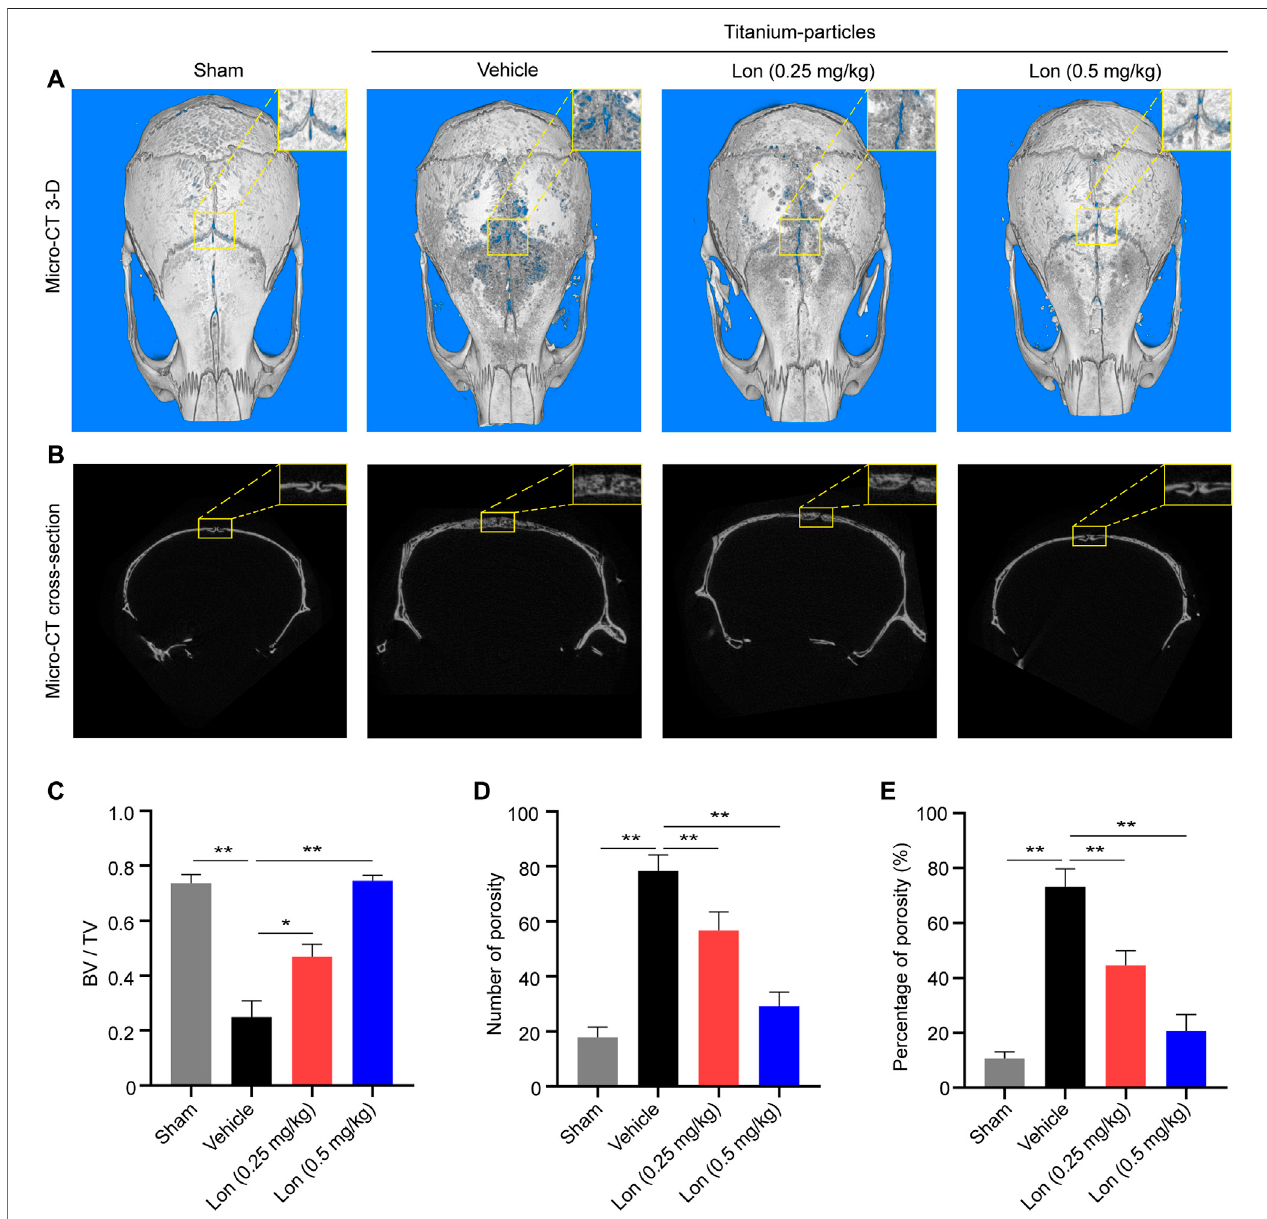
FIGURE3 | Lonprevents titanium particle-induced osteolysis and bone loss in vivo . (A) RepresentativeMicro-CT3-D constructional images showing thattitanium particle-induced osteolysis was prevented by Lon administration. (B) Representative cross-section images showing that titanium particle-induced osteolysis was preventedbyLonadministration. (C) BV/TVvalues (D) numberofporosityand (E) percentageofporosityofROIwerequanti fi edtoassessbonemicrostructure.Allofthe above data are expressed as the mean ± SD, n = 5 per group. * p < 0.05, ** p < 0.01 relative to Vehicle group. BV/TV, bone volume/tissue volume values; Lon, Lonafarnib; ROI, region of